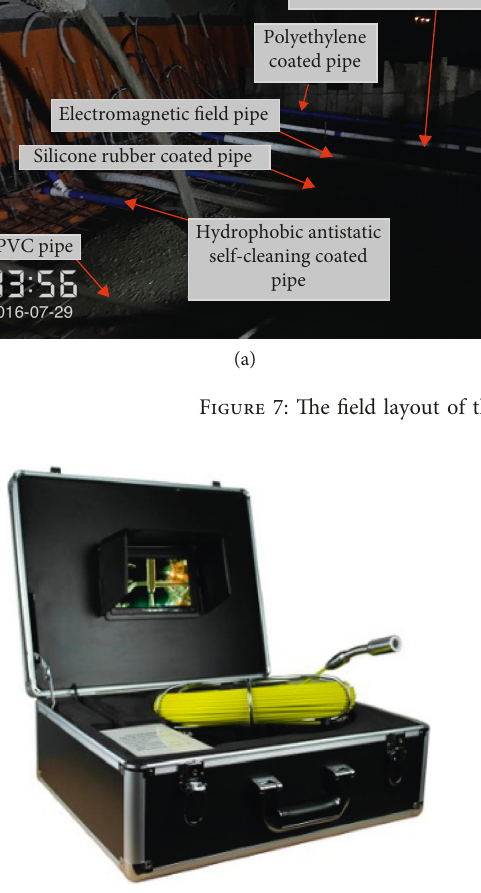
Figure 8: Pipe endoscope. Table 3: Main functional parameters of the pipe